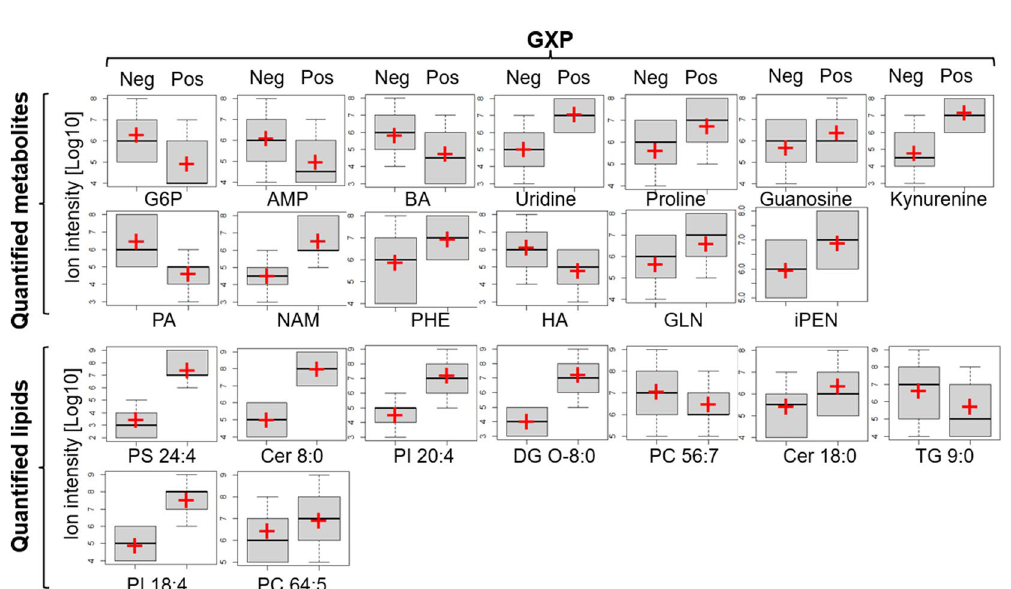
Figure 7. Standard error distribution of metabolites and lipids that were significantly different in GXP- negative and GXP-positive groups across all three visits. Red crosses indicate the mean values. G6P: d-glucosamine-6-phosphate; AMP: adenosine monophosphate; BA: butanoic acid; PA: palmitic acid; NAM: n-acetylmuramic acid; PHE: phenylalanine; HA: hyocholic acid; GLN: glutamine; iPEN: isopentenyladenine; PS: phosphatidylserine; Cer: ceramides; PI: phosphatidylinositol; DG: diacylglycerol; PC: phosphatidylcholine; TG: